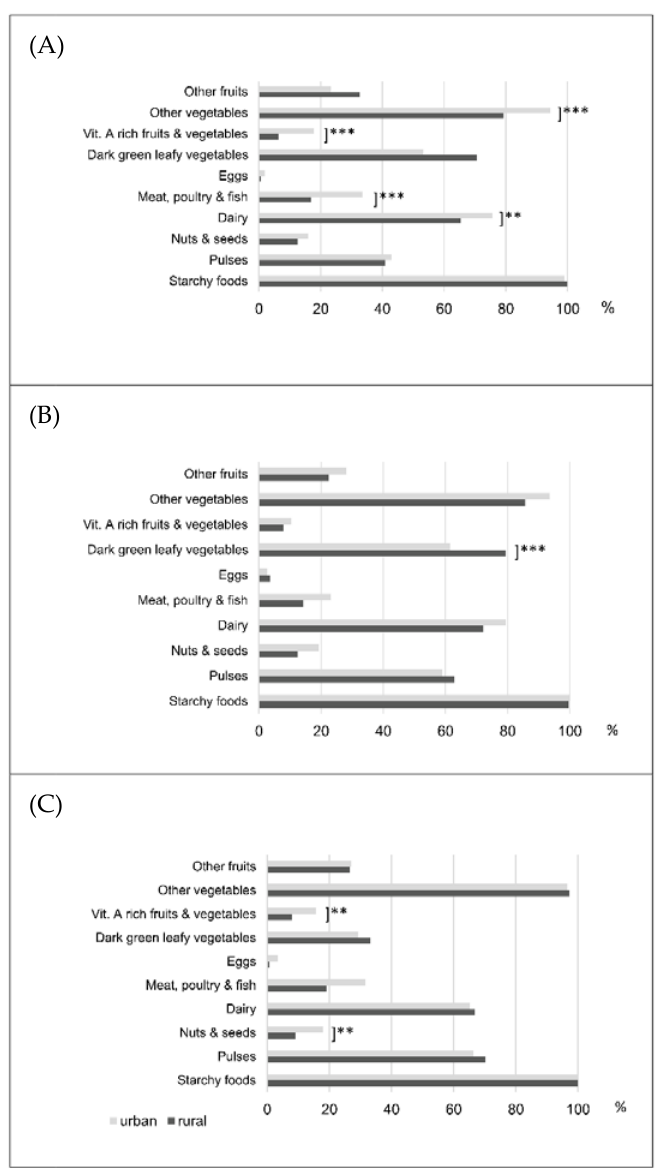
Figure 2. Food consumption pattern among women in rural and urban areas of the Kapchorwa District, Uganda, across agricultural seasons: ( A ) lean season: baseline in May/June 2016; ( B ) harvest season: 1st Follow-up in August 2016; ( C ) post-harvest season: 2nd Follow-up in January 2017; p -values statistically significant at ** p < 0.05 or *** p < 0.001